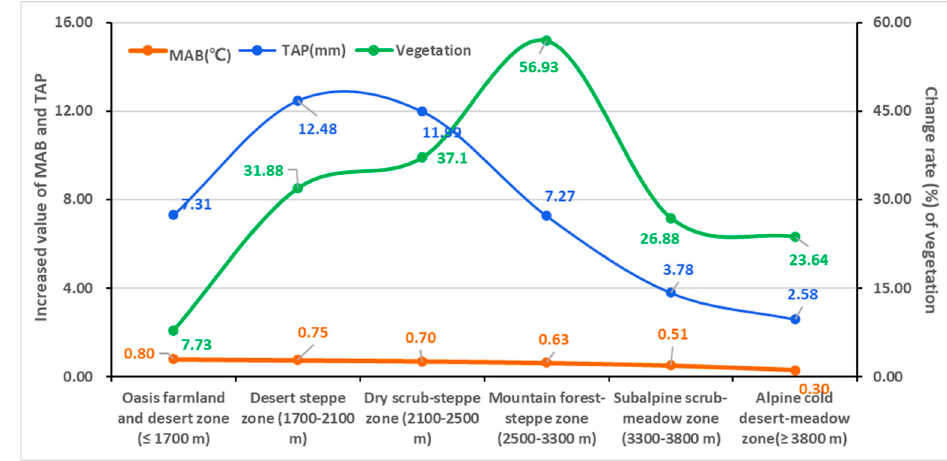
Figure 8. Change trends of vegetation, MAB, and TAP in the different zones.